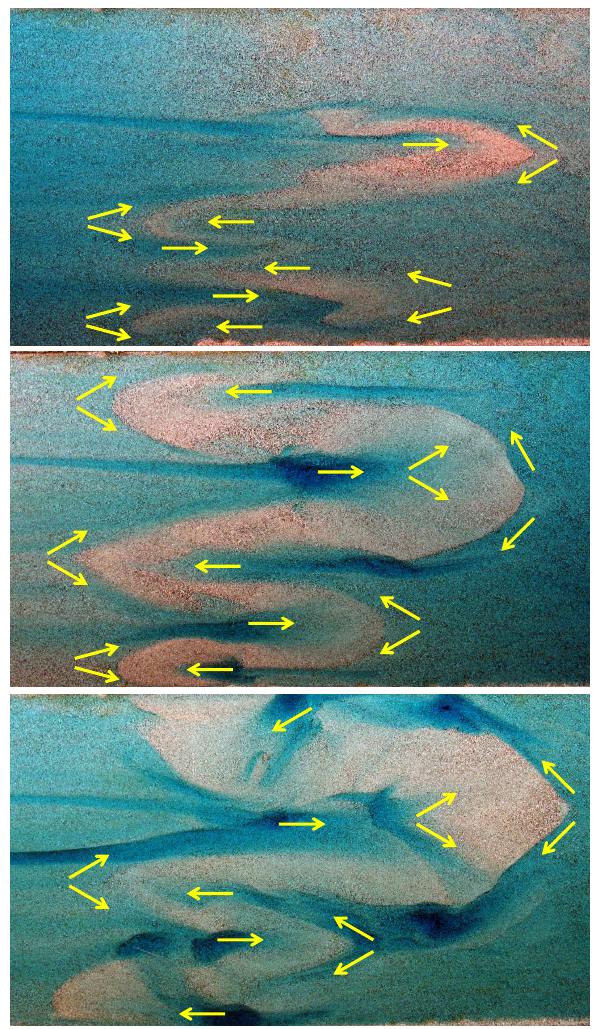
Fig. 5. Top view on diamond-shaped tidal bars in high-energy ex- periment 4 after about 500, 1000 and 3000